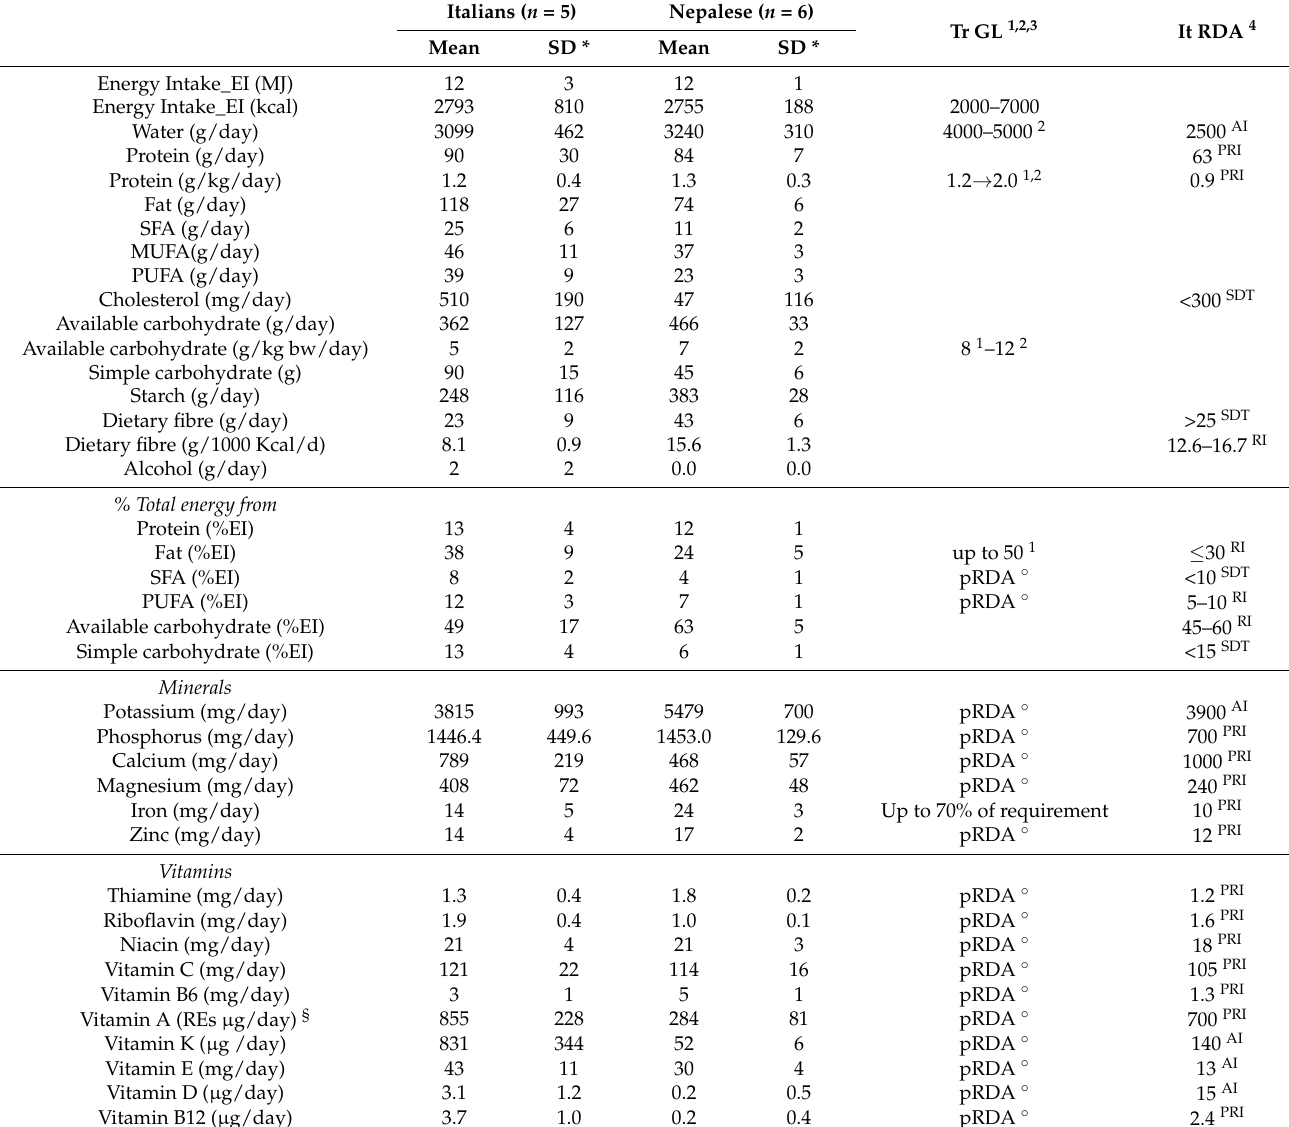
Table 3. Mean daily energy and nutrient intakes for Italian and Nepalese group, expressed as mean ± SD, % of Energy Intake, and nutrition guidelines for moderate/high-intensity training (tra GL 1,2,3 ) and Recommended daily allowances of nutrient intake for the generic population (It RDA 4